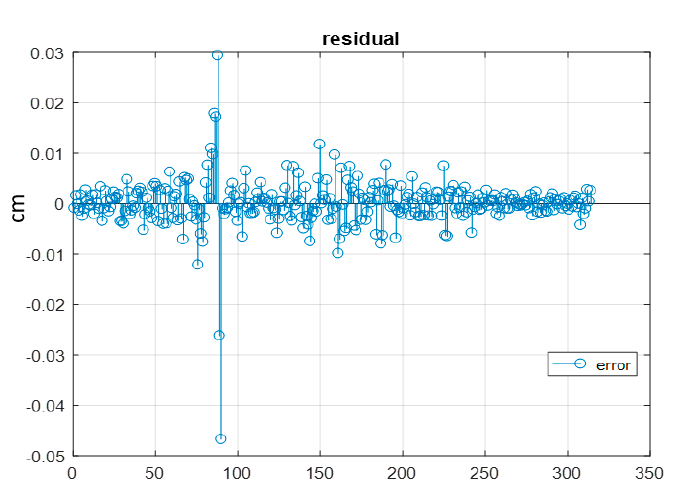
Figure 14. Residual at the final iteration. Figure 13. Normal matrix with all object points constrained by inner matrix G and Geometric Constraint. Table 5. The calculated final 3D ground coordinates of the accuracy of the tie points.